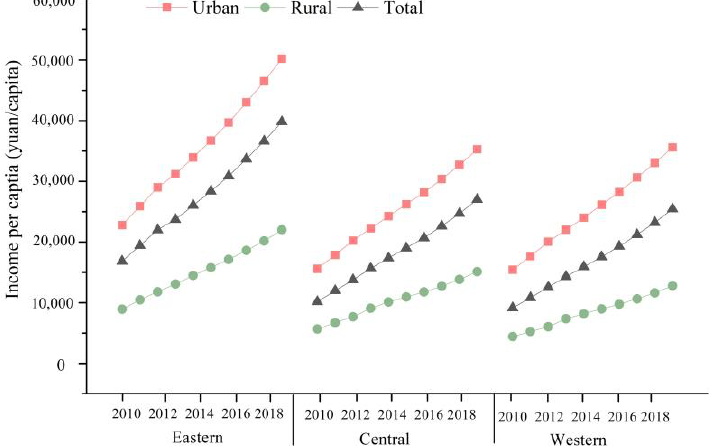
Figure 6. Changes in per capita income of urban and rural residents in the three different regions of China during 2010 – 2019. China during